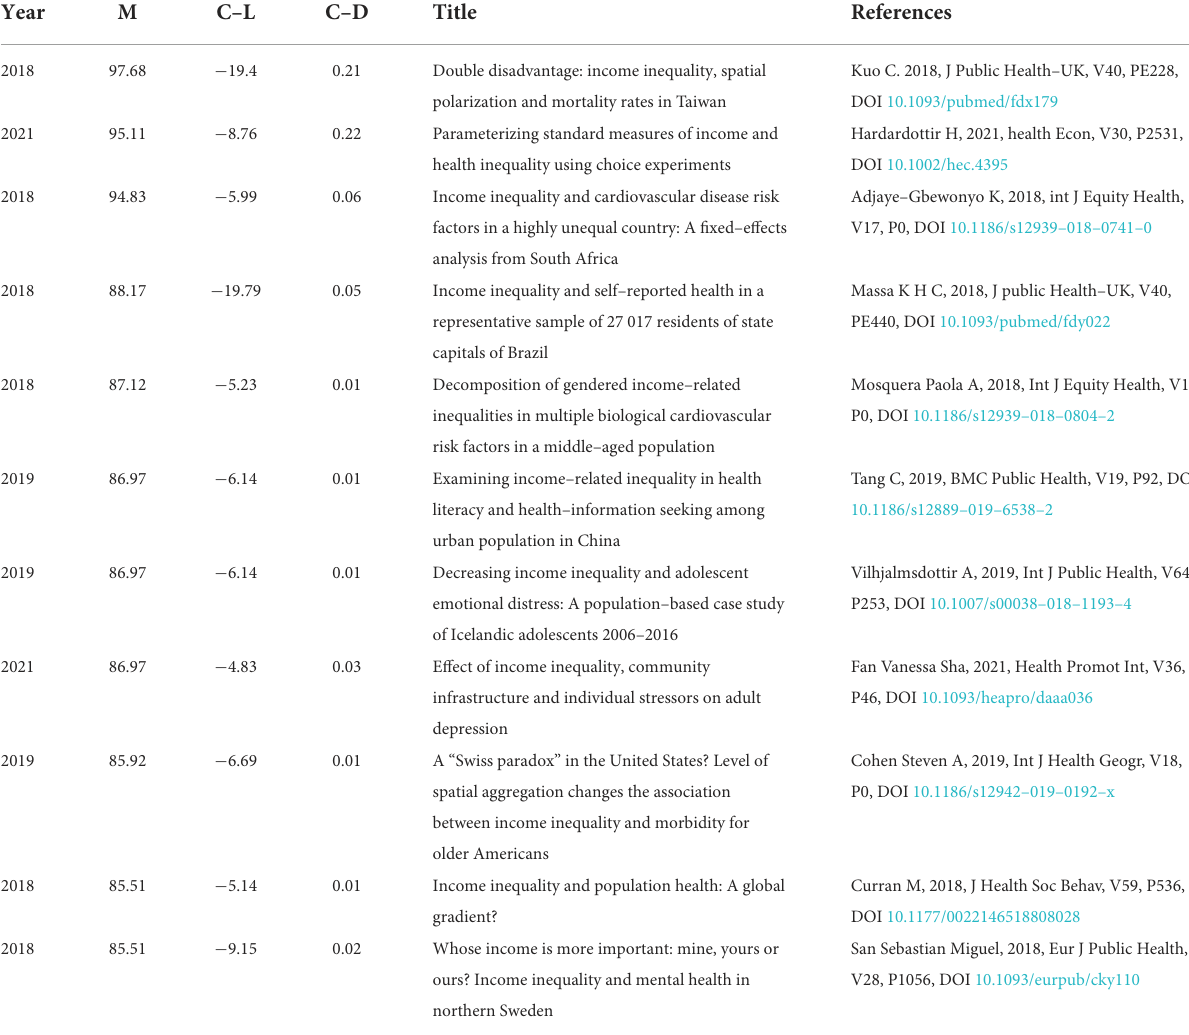
TABLE 8 Some of the articles with the strongest transformative potentials, M( 1 Modularity), C-L( 1 Cluster Linkage), and C-D( 1 Centrality